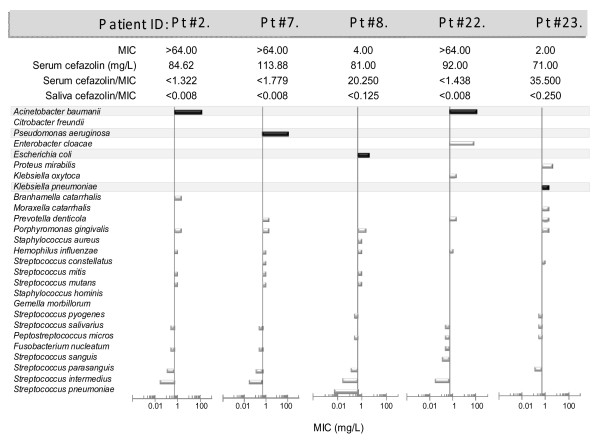
Comparison of the minimal inhibitory concentration (MIC) of cefazolin regarding the bacteria isolated preoperatively from the saliva and postoperatively from the sputum. Cefazolin resistant pathogenic, Gram negative bacteria isolated from the saliva pre-operatively, were also grown from the sputum of the postoperative pneumonia patients. The vertical axis of the graphs crosses the x axis at 0.5 mg/L. The antibiotic level of all the sputum samples fell below 0.5 mg/ml. The bars indicate the MIC value of bacteria obtained pre-operative from the saliva. Black bars denote the bacteria that were cultured from both the sputum and the saliva of the same patient.